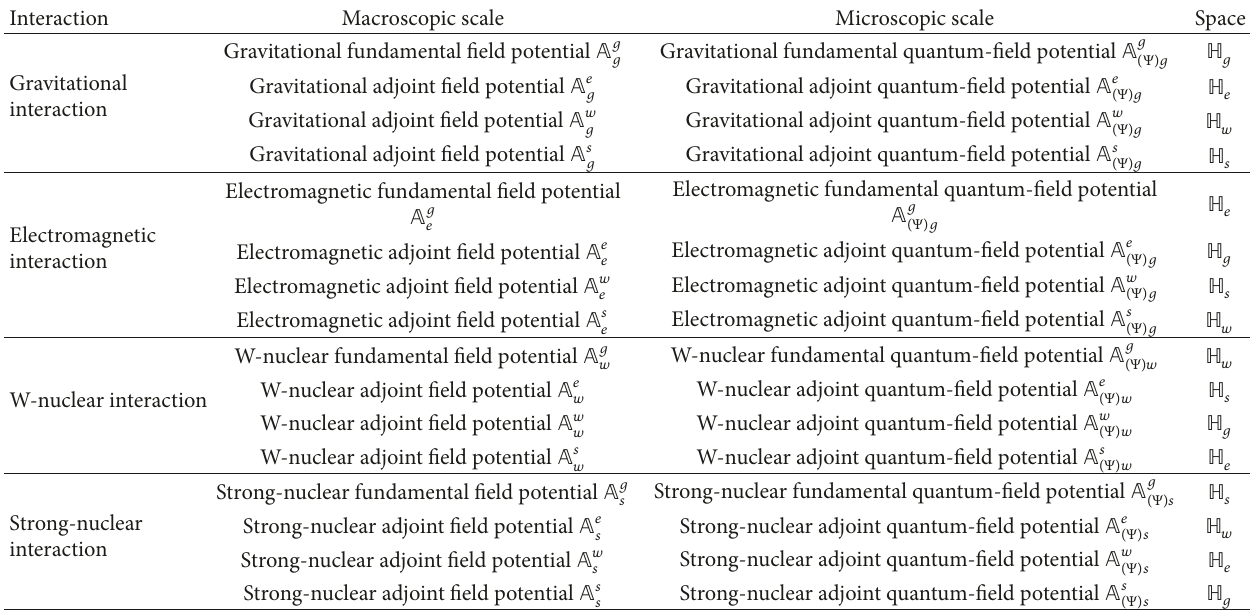
Table 5: There are four sorts of fundamental interactions in the complex sedenion spaces, including their field potentials of fundamental fields and adjoint